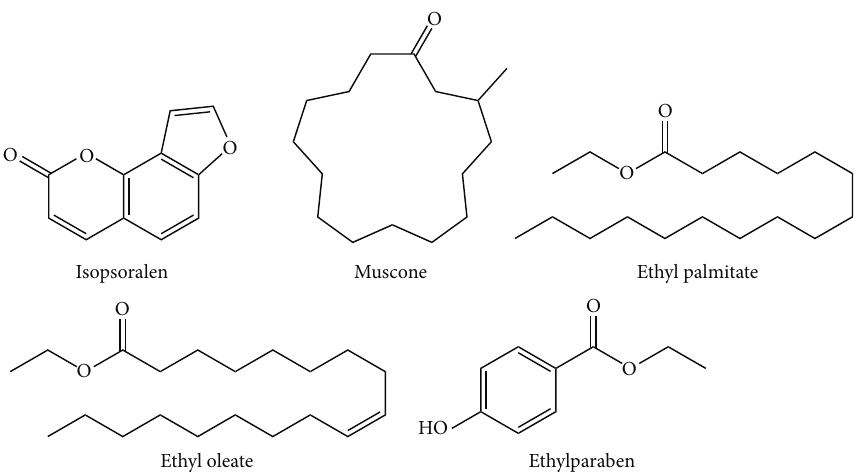
Figure 1: The structure of isopsoralen (IS) and multiple compounds in the